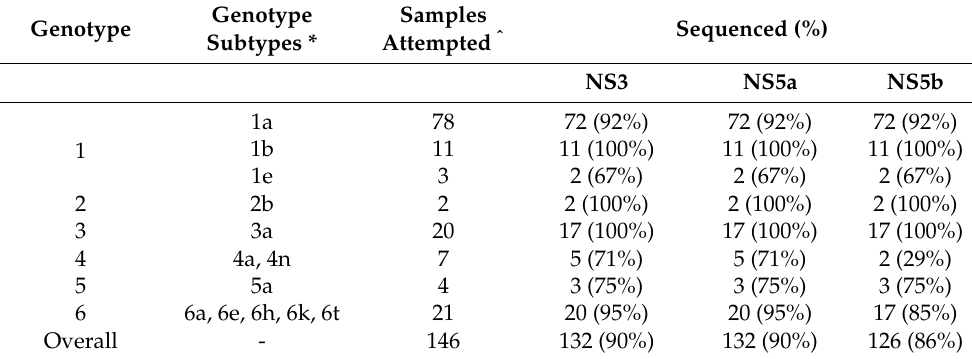
Table 3. Sequencing success for the HCV NS3, NS5a and NS5b genes using the genotype-independent- HCV assay for genotypes